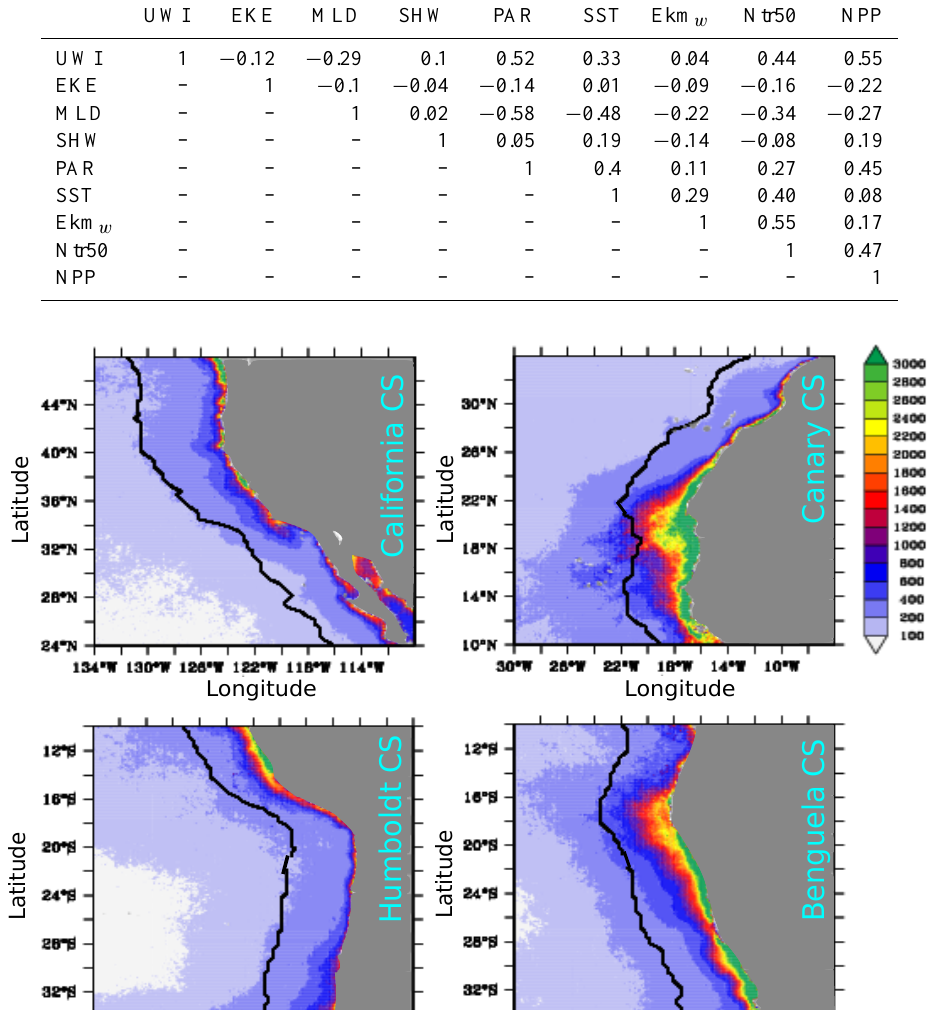
Table 2. Pearson correlation coefficient ( r ) between the potential drivers and NPP.